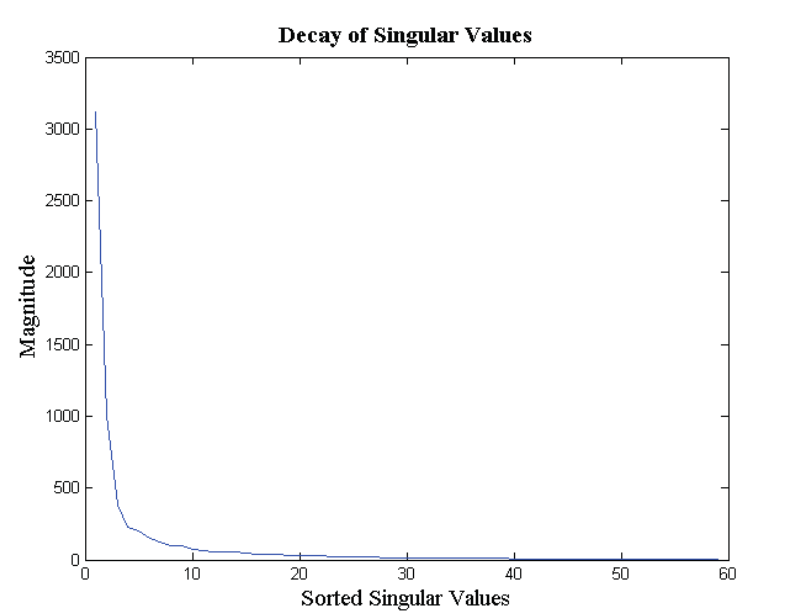
Figure 2. Decay of singular values for a multi-channel signal